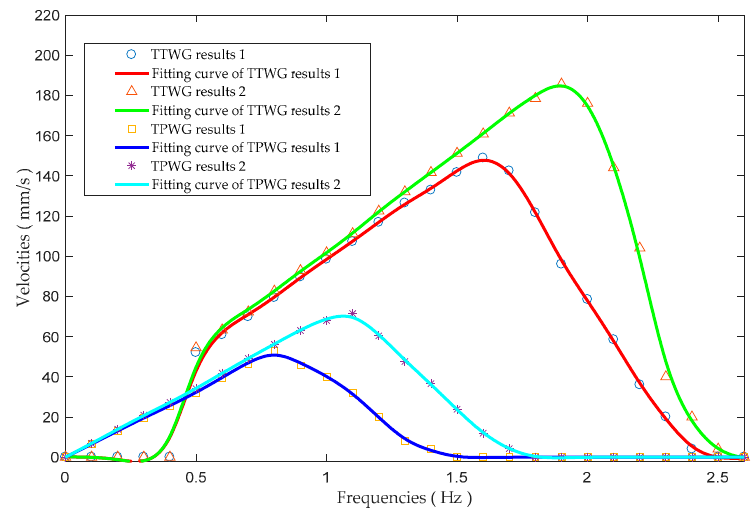
Figure 16. The velocities of gaits of different frequency on smooth flat, and rough, substrates. The deep-sky-blue circles and the coral triangles indicate the experimental TTWG data on smooth, flat and rough terrain, and the orange squares and the purple asterisks indicate the experimental TPWG data on smooth, flat and rough terrains. The red, green, blue and cyan curves are the corresponding fitting curves.